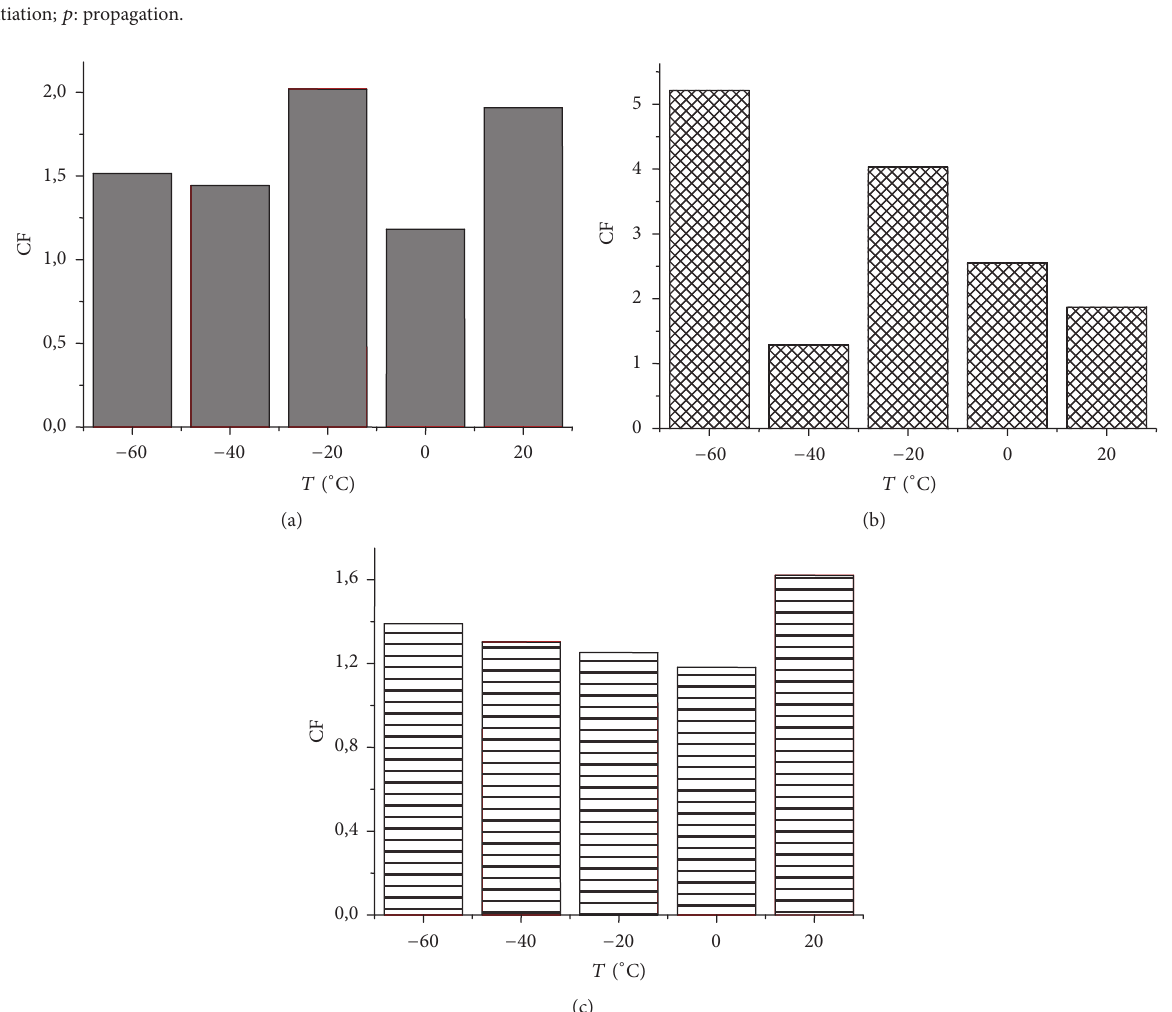
Figure 2: Temperature dependence of the CF parameter for 17Mn1Si steel specimens with V-notch (a), U-notch (b), and I-notch (c).